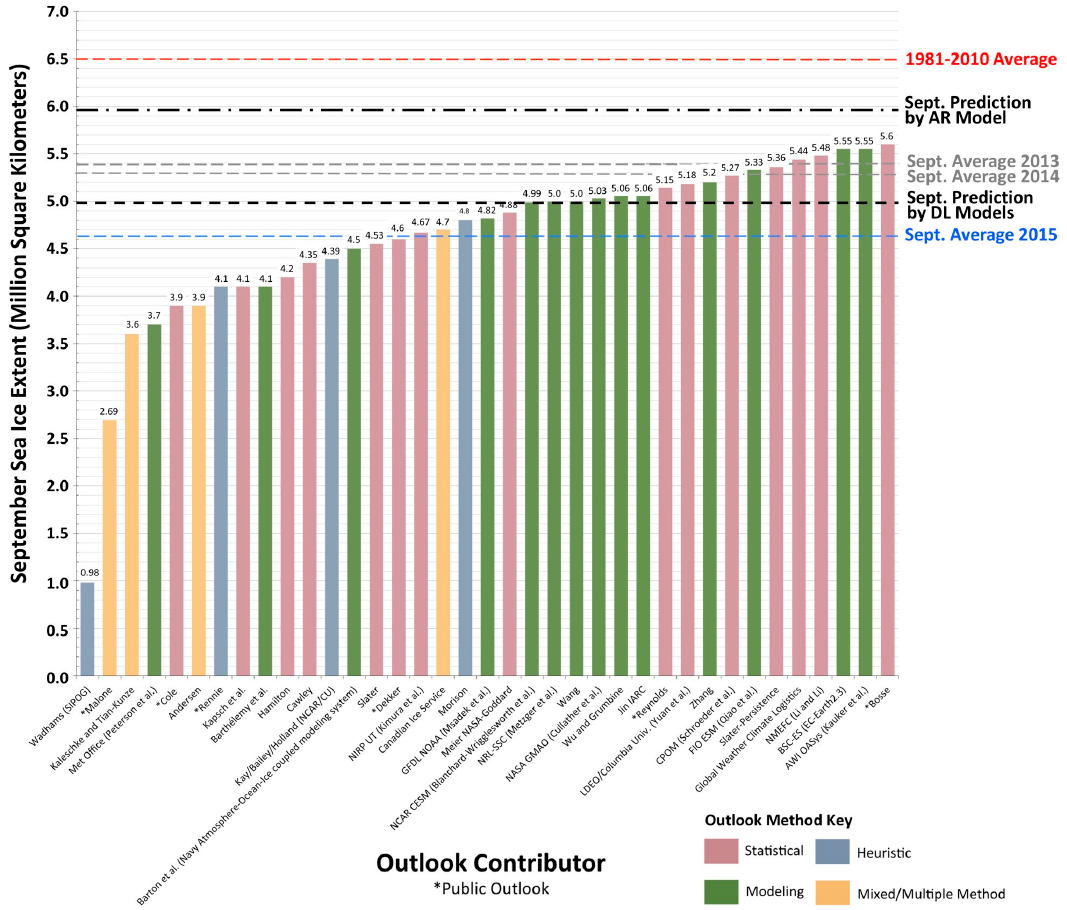
Figure 9. Distribution of Arctic Outlook values (August report) for September 2015 extent. (This figure is adapted from the Sea Ice Prediction Network (SIPN) and modified by adding our results.).